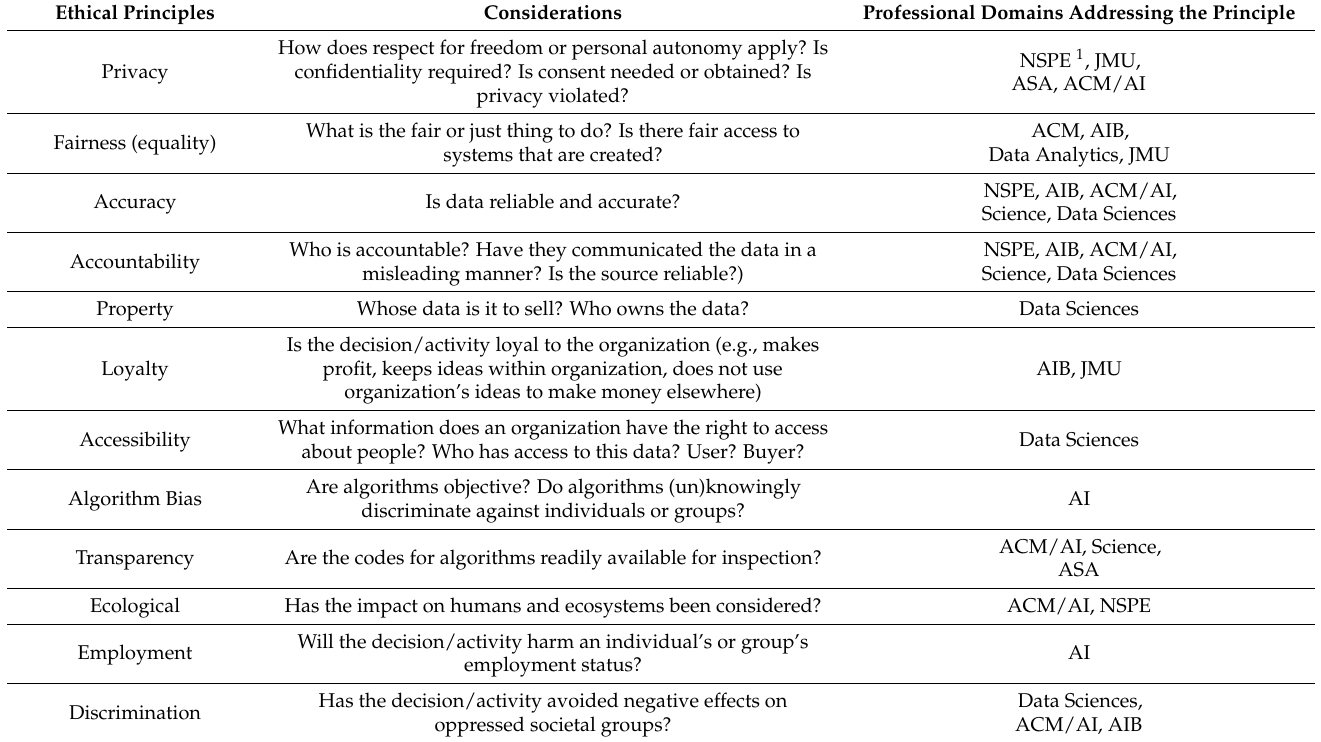
Table 1. Ethical Reasoning in Mathematics Analytic